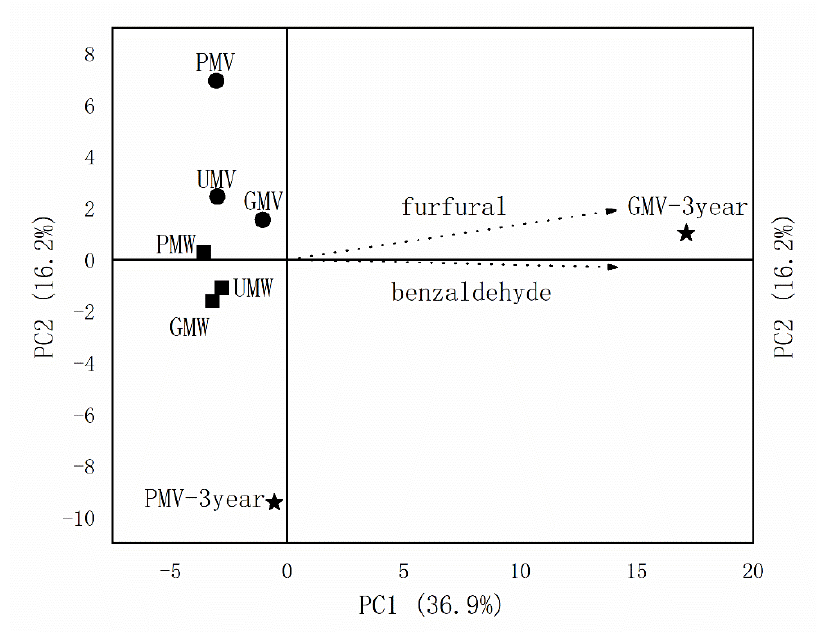
Figure 7. Principal component analysis (PCA) of the obtained MWs and MVs. Abbreviations: ■ MW: PMW- Monascus wine using polished rice as raw material, UMW- Monascus wine using unhusked rice as raw material, GMW- Monascus wine using germinated rice as raw material. ● MV: PMV- Monascus vinegar using polished rice as raw material, UMV- Monascus vinegar using un-